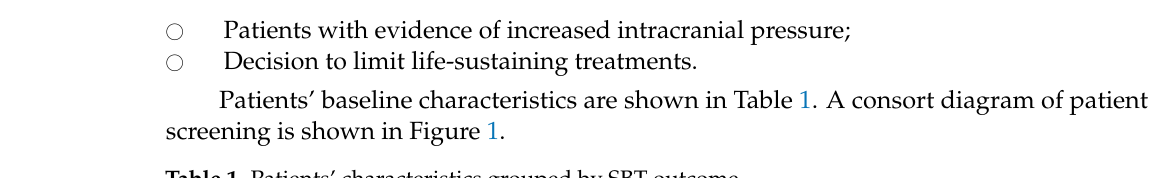
Table 1. Patients’ characteristics grouped by SBT outcome.